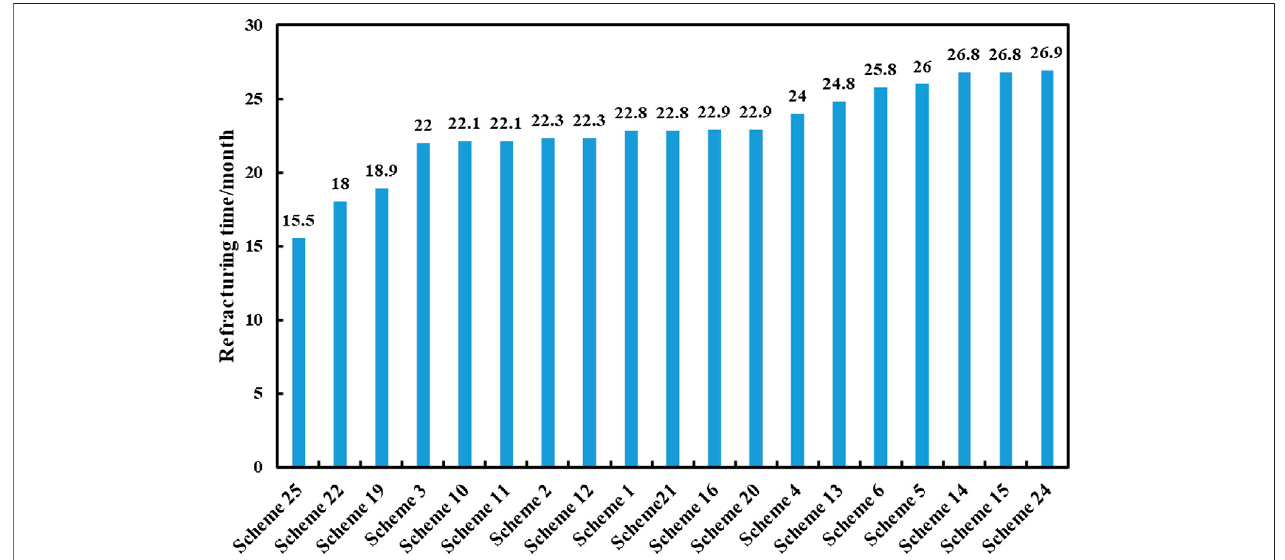
FIGURE 6 | Refracturing timing sequence under different initial fracturing modes.